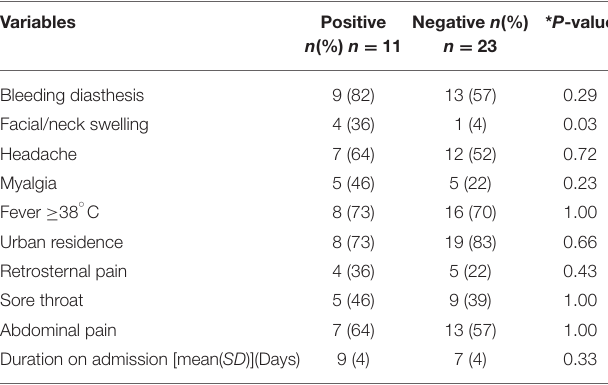
TABLE 2 | Clinical and epidemiological factors associated with confirmed vs. negative Lassa fever